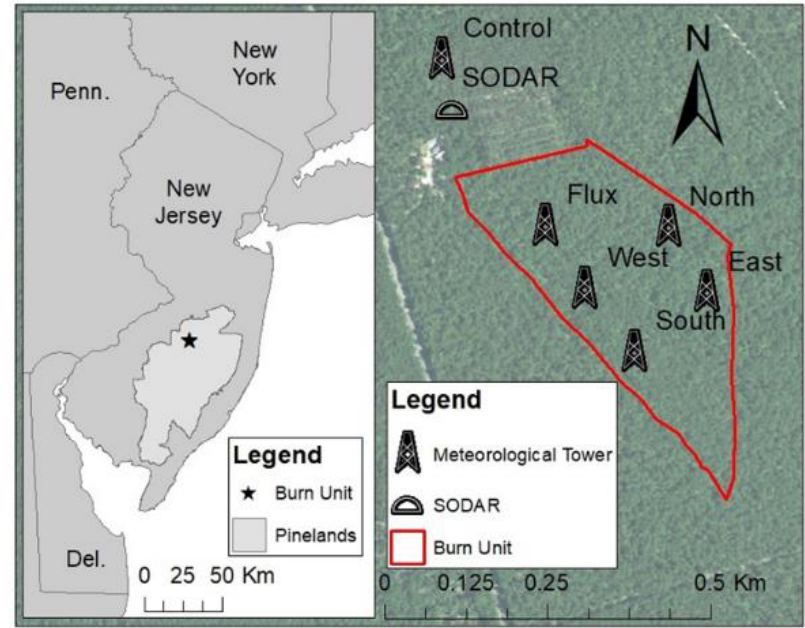
Figure 1. The location of the 13 March 2019 SERDP management-scale prescribed fire experiment in the New Jersey Pinelands National Reserve ( left panel ); and the prescribed fire burn unit along with the meteorological tower and SODAR system locations ( right panel ).